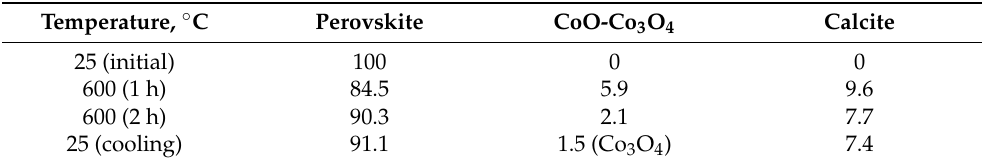
Table 1. Phase composition for La 0.5 Ca 0.5 Mn 0.5 Co 0.5 O 3 in different thermal treatments (weight fraction %). Temperature, ◦ C Perovskite CoO-Co 3 O 4